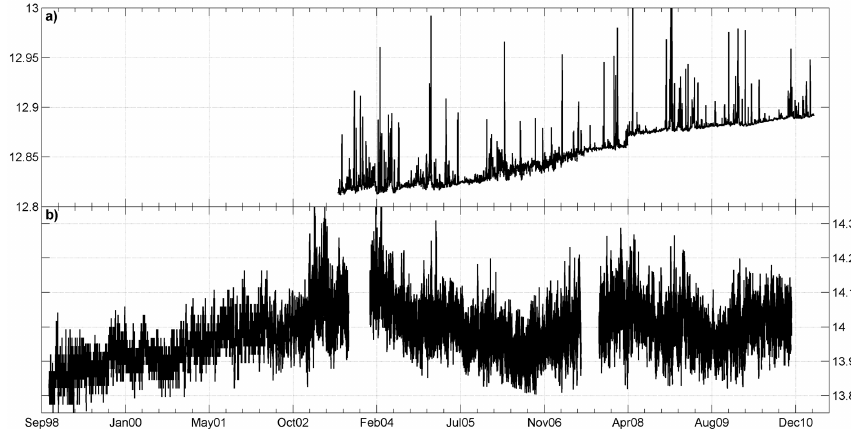
Fig. 8. (a) θ time series at SC (at 1900m), (b) θ times series in at C01 (at 387m).